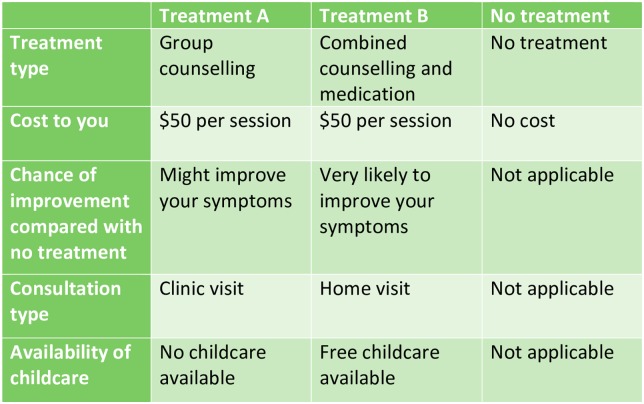
Sample choice set.